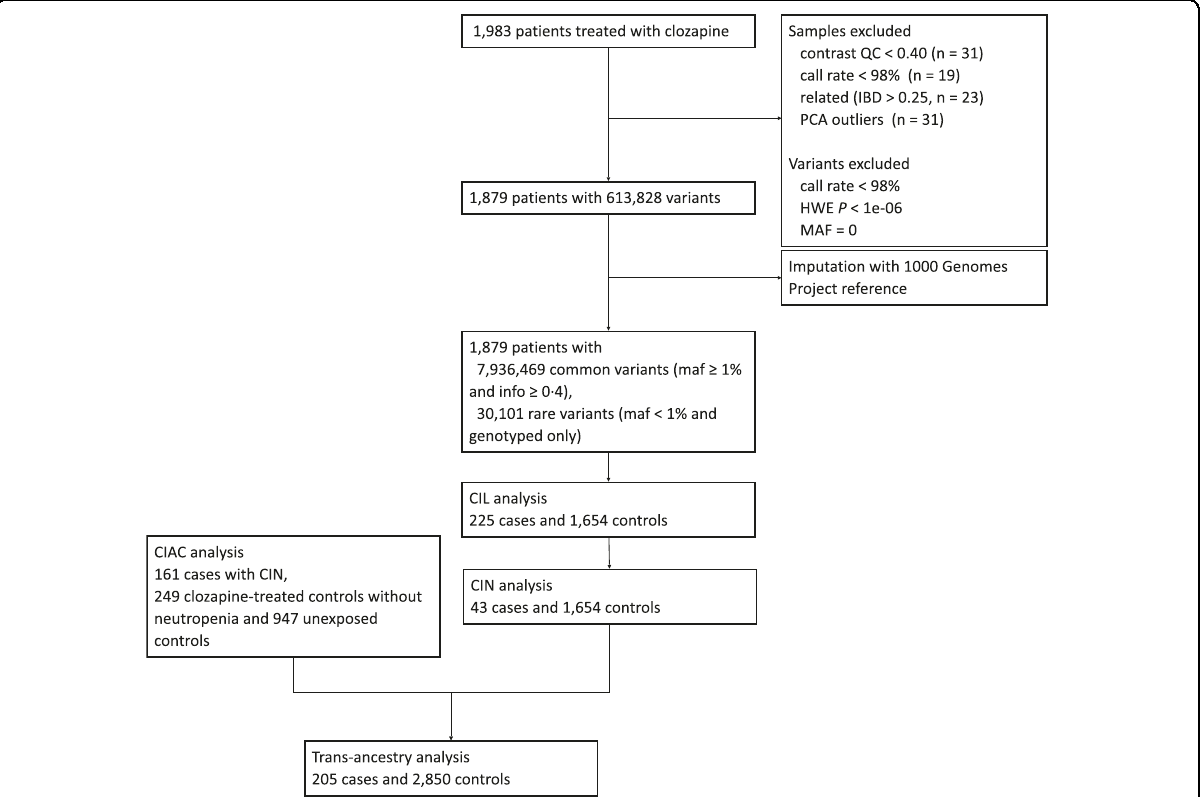
Fig. 1 Flowchart for the study design. QC: quality control; IBD: identity-by-descent; PCA: principal component analysis; HWE: Hardy-Weinberg equilibrium; MAF: minor allele frequency; CIL: clozapine induced leukopenia; CIN: clozapine induced neutropenia; CIAC: Clozapine Induced Agranulocytosis